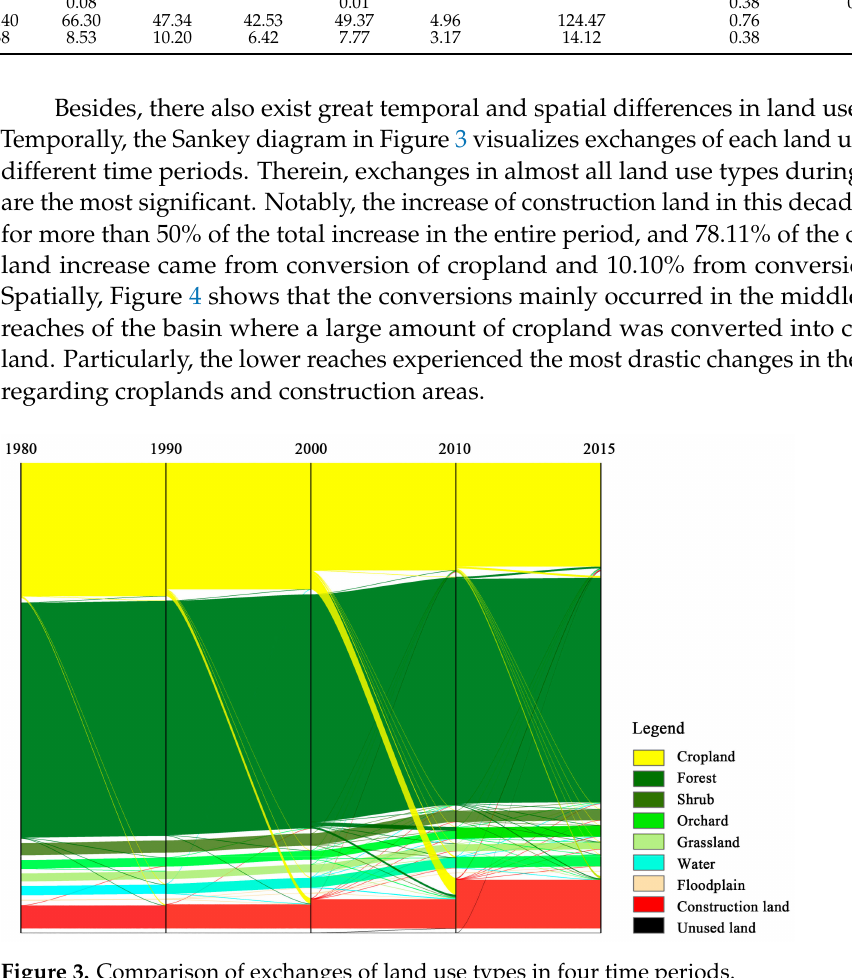
Figure 3. Comparison of exchanges of land use types in four time